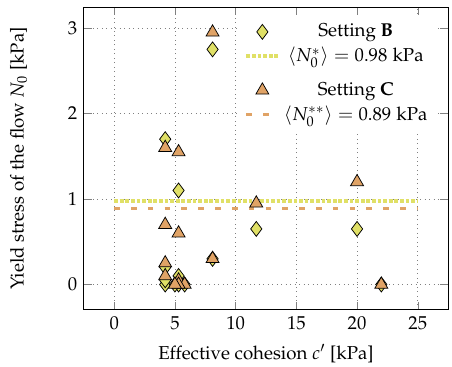
Figure 6. Comparison between back-calculated yield stress values of the flow N ∗ cohesion c (cid:48) according to the Swiss standard [59] for each soil class.